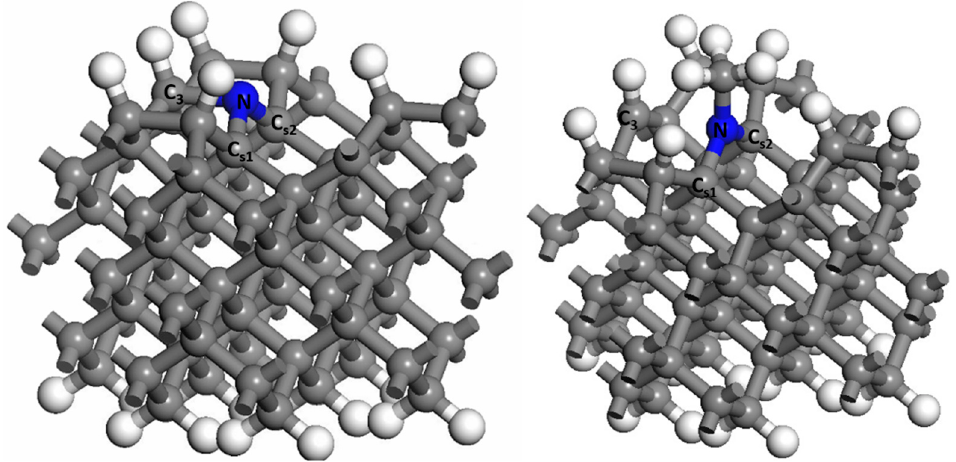
Figure 5. The model structure of N-doped diamond (100) surface before and after the CH 3 adsorption.